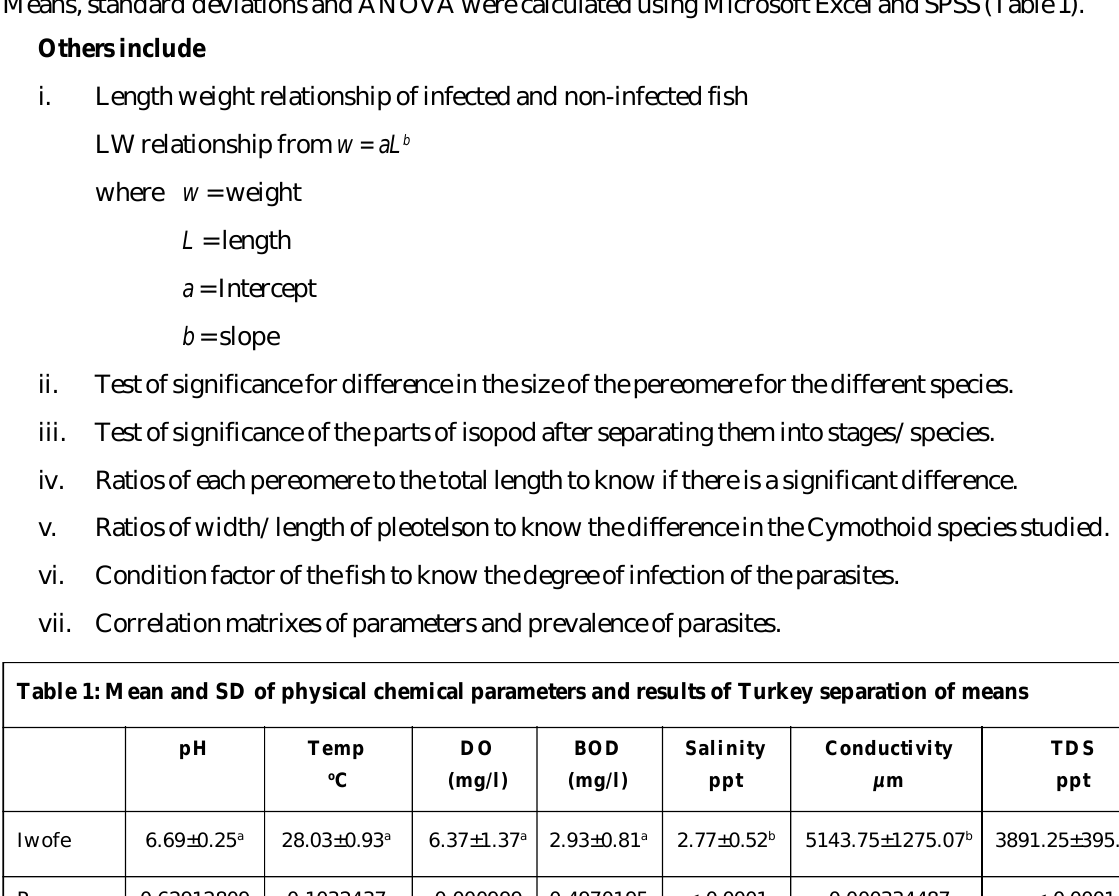
Note: ab shows mean comparison are significantly